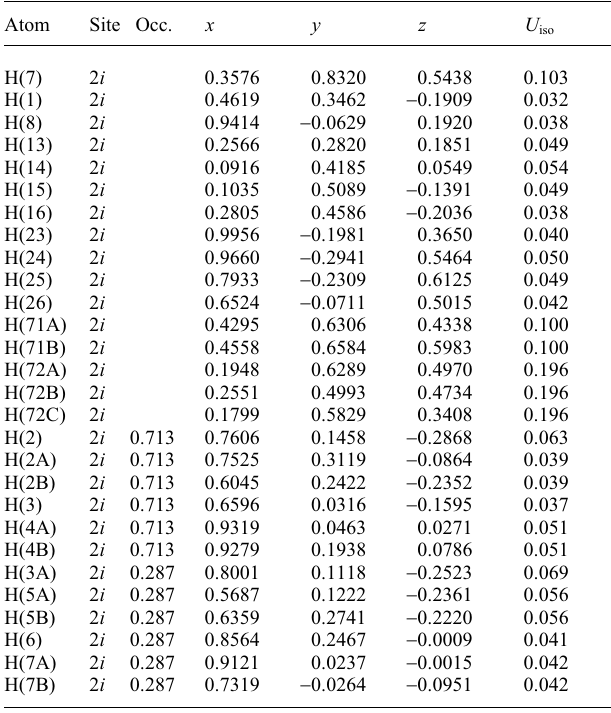
Table 2. Atomic coordinates and displacement parameters (in Å 2 ) .